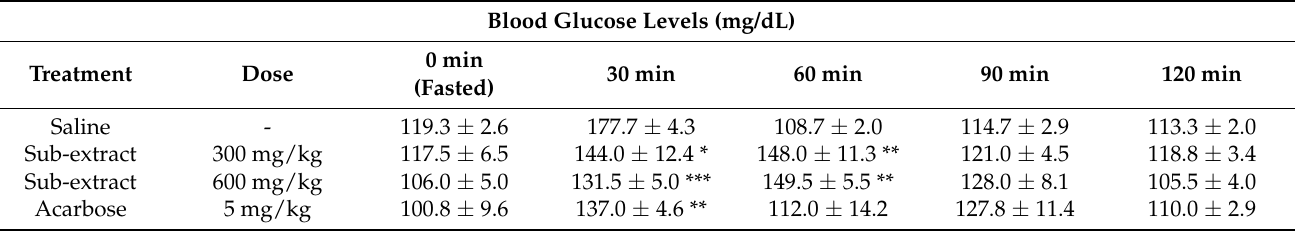
Table 3. Blood glucose levels of TFE (300 mg/kg), TFE (600 mg/kg) and acarbose (5 mg/kg)-treated healthy rats for fasting and OGTT.